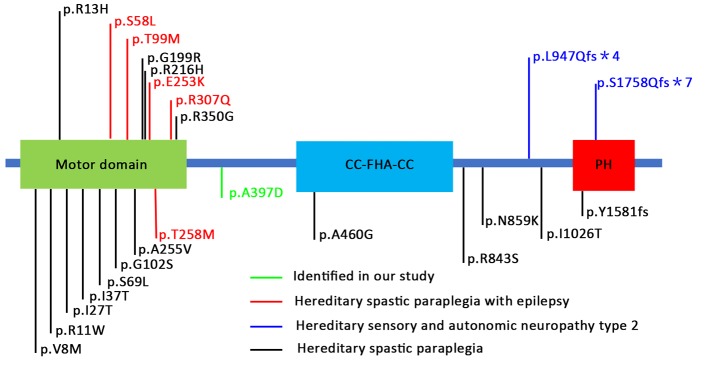
Schematic representation of KIF1A protein and locations of mutations in human KIF1A associated with various neuronal disorders. These mutations are distributed in various locations and domains of the KIF1A subunit protein peptide (Niwa et al., 2016; Iqbal et al., 2017
; Riviere et al., 2011; Chiba et al., 2019).